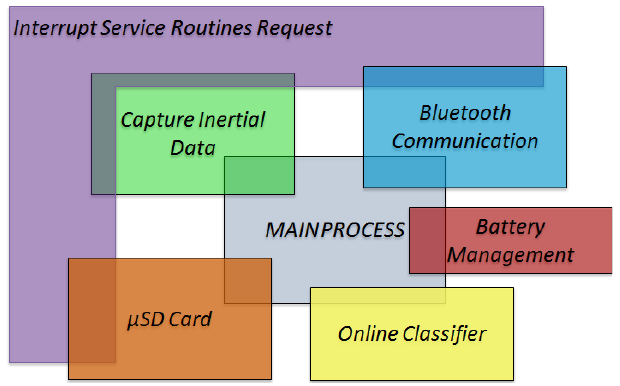
Figure 5. Firmware’s processes